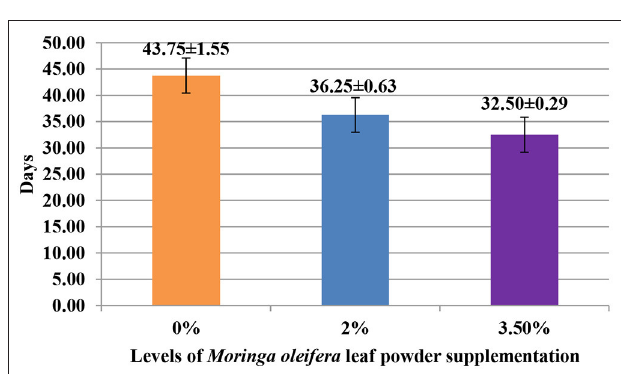
FIGURE 2 | Effect of Moringa oleifera leaf powder supplementation on onset time (days) of first postpartum estrus after kidding in Beetal goats.